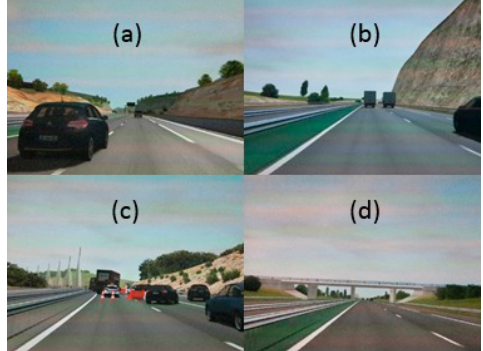
Figure 5. The four tasks encountered by the drivers along the track. ( a ) The “overtake” task. ( b ) The “trucks” task. ( c ) The “narrow” task. ( d ) The “wind”